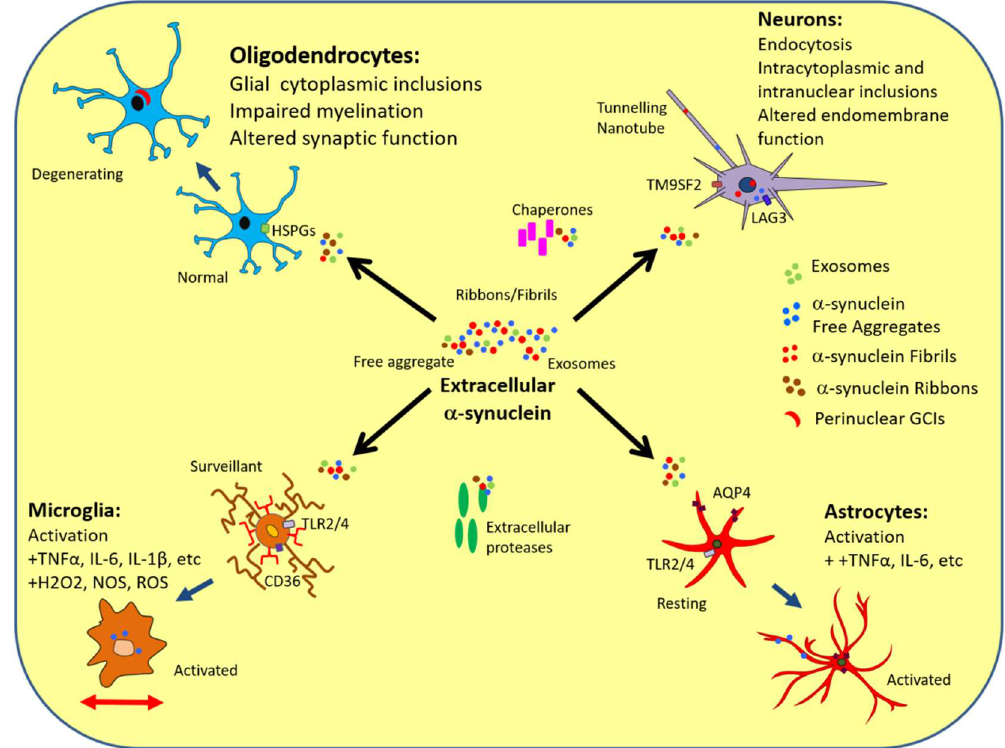
Figure 1. Interactions of α-synuclein with CNS cell types and the extracellular matrix in multiple system atrophy. α-Syn is released by neurons via either exocytosis or membrane leakage due to apoptosis, necrosis, or other damage. Neurons have LAG3 and TM9SF2 receptors on the surface which when bound by fibrillar α-syn, mediate clathrin-dependent endocytosis. Tunneling nanotubes can mediate α-syn transfer between various cell types. Released α-syn can interact with extracellular proteases and chaperones. Astrocytes detect α-syn and signal for microglial recruitment by inflammatory factors. This also has the effect of activating microglia from the surveillant state to the phagocytic phenotype. Activation is also caused when microglia detect α-syn either in exosomes or free in the extracellular matrix. Astrocytic activation could lead to loss of aquaporin-4 polarization to endfeet and dysregulation of glymphatic circulation. Oligodendrocytes can take up α-syn -containing exosomes from neurons via endocytosis and mediated by surface heparin sulfate proteoglycans (HSPGs). Microglia can engulf exosomes via macropinocytosis. Microglia perform phagocytosis on free and exosome-associated α-syn. Microglia undergo clathrin-mediated endocytosis as well as activation by CD36 scavenger receptor and toll-like receptors (TLRs) and can spread α-syn pathology by migrating away from the site of uptake.